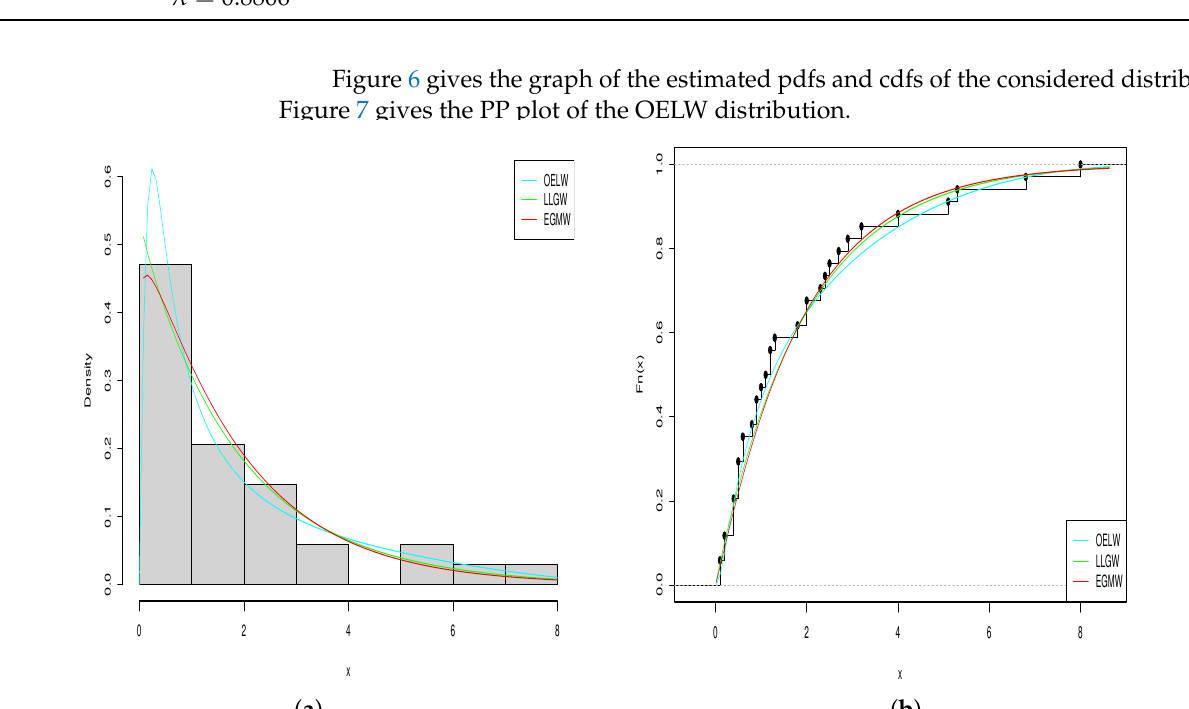
Figure 6. Obtained plots of the ( a ) estimated pdfs and ( b ) estimated cdfs of the considered distribu- tions for the vinyl chloride data